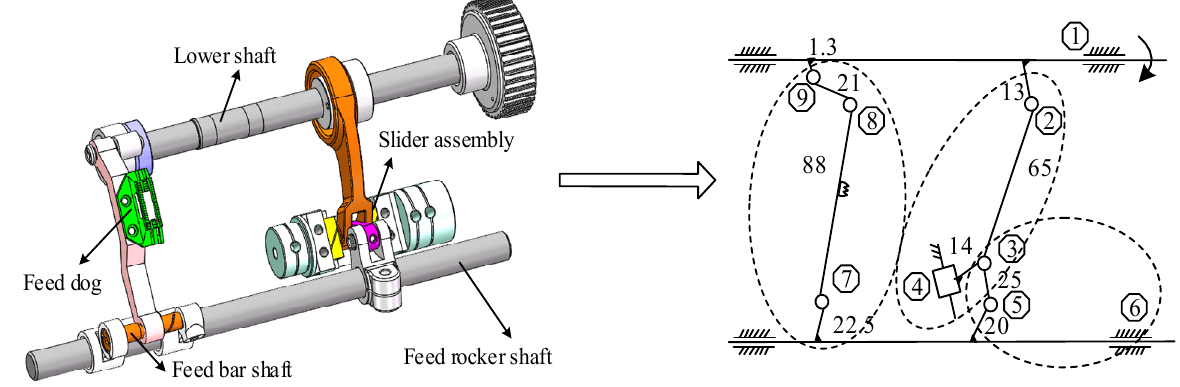
Figure 4. Source metamorphic mechanism of the feed mechanism.